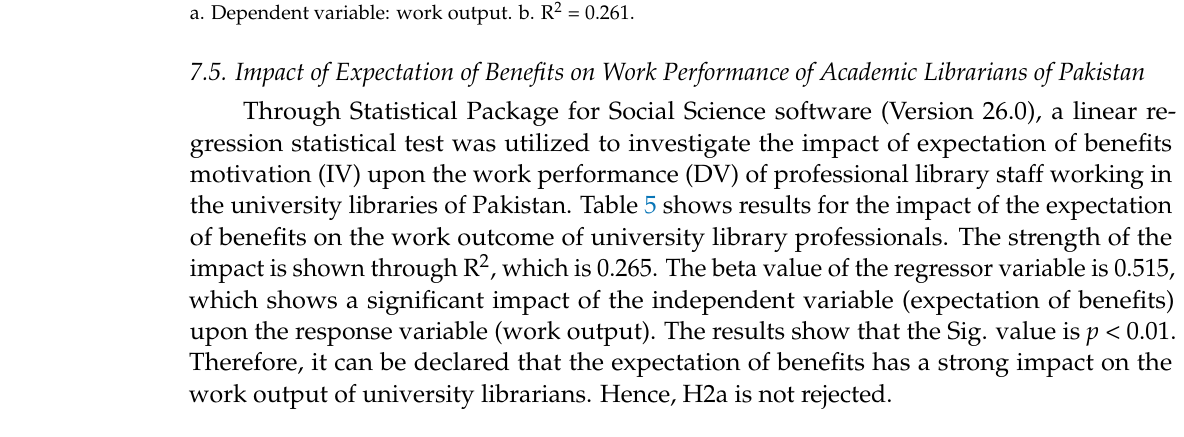
Table 5. Impact of expectation of benefits on work